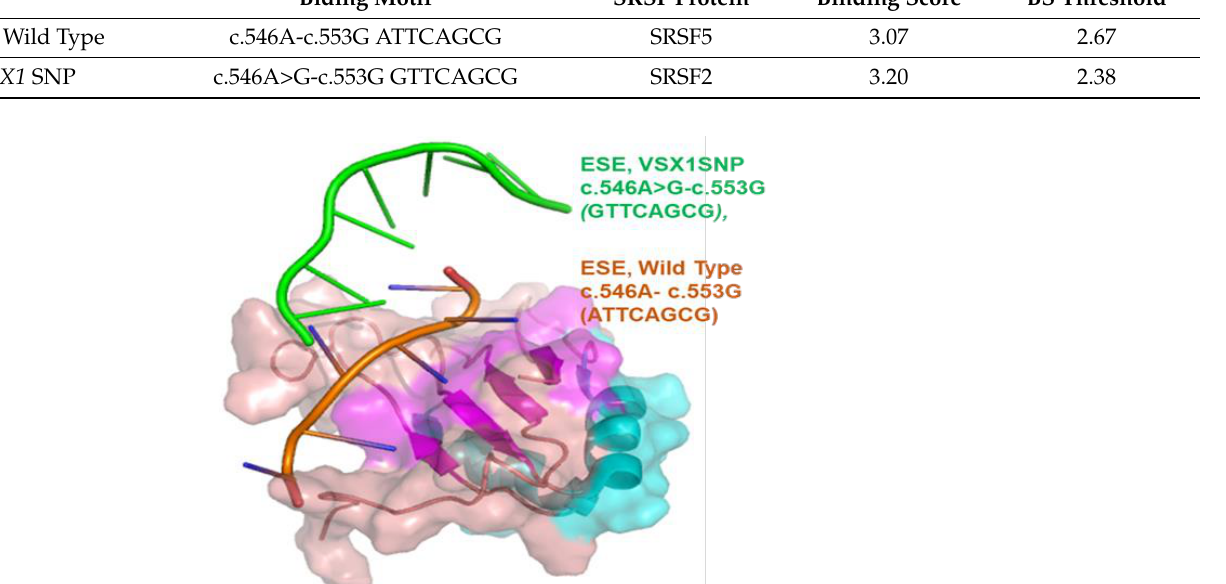
Table 4. Variations in binding properties of miRNA-203 and miRNA-3938 with VSX1 3′UTR (WT) as predicted by miRANDA and PITA. Figure 3. ESE elements, VSX1 Wild Type c.546A-c.553G (ATTCAGCG) shown in brown and VSX1